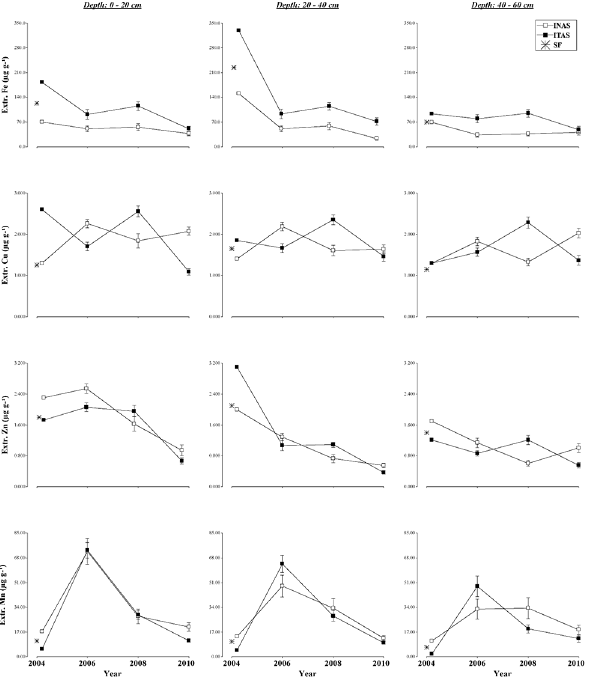
Fig 5. Changes in soil chemical properties. Under long term agroforestry management systems (INAS, ITAS) as compared to soil properties of SF at different depths (0 – 20, 20 – 40, 40 – 60 cm) during 2004 to 2010 experimental